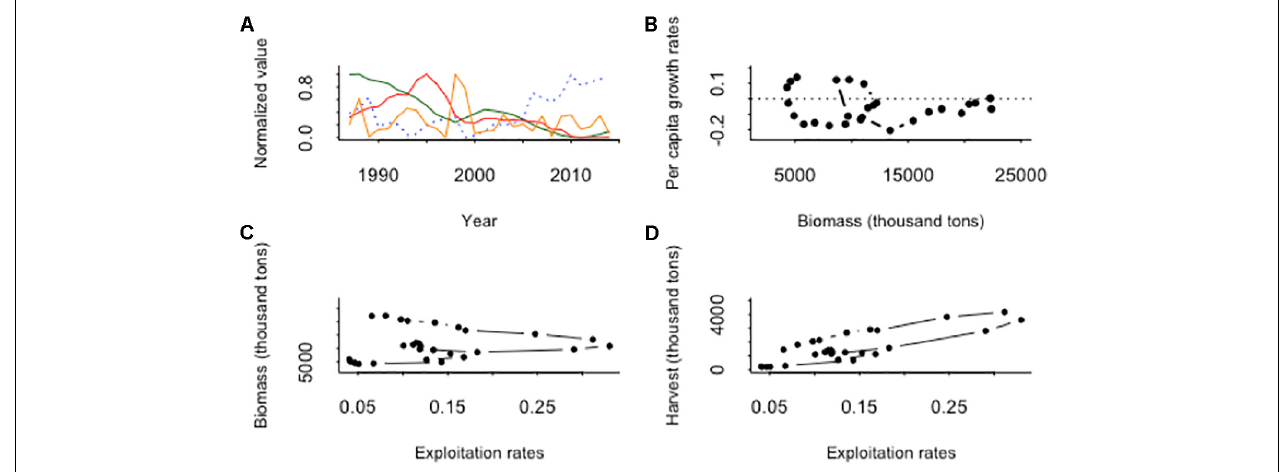
FIGURE 1 | (A) Observed dynamics of the jack-mackerel fish stock biomass (green solid line), harvest (red solid line) and inflation-corrected price (blue dotted line), and the Niño 3.4 anomalies (orange solid line) for the period 1986–2015. (B) The phase plot of the per capita population growth rates against biomass showed a low-frequency oscillatory pattern in the jack mackerel dynamics toward low biomass. (C) The relationship between stock biomass (thousand tons) and exploitation rates (fishing mortality) for the period 1986–2015, stock biomass declined with exploitation rates, but the reduction in exploitation rates did not caused a recovery of the stock, during the late period much lower stock biomass are observed for the same range of exploitation rates. (D) The observed relationship between stock yield and exploitation rates for the period